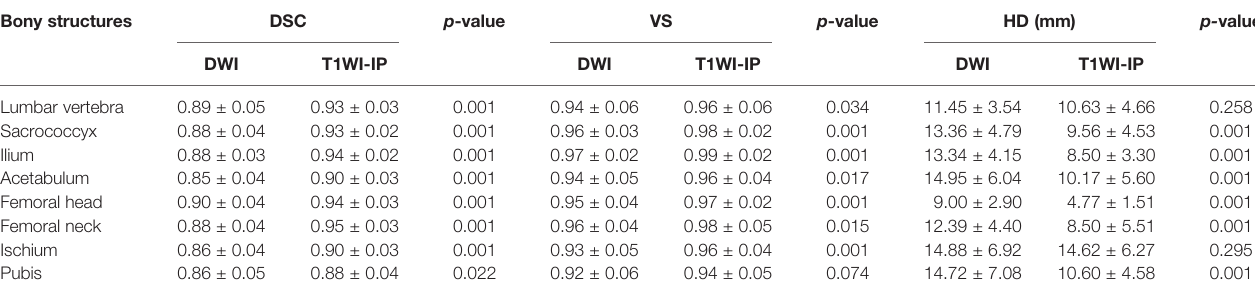
TABLE 4 | Segmentation performance of pelvic bony structures. Bony structures